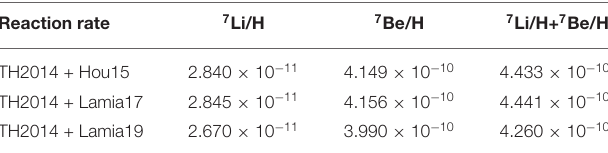
TABLE 7 | Predicted primordial abundances of 7 Li, 7 Be, and their sum, inserting reaction rates from Pizzone et al. (2014) ( Table 6 ) and the 7 Be(n, α ) 4 He from Hou et al. (2015) in the first line, Lamia et al. (2017) in the second, and Lamia et al. (2019) in the third. Reaction